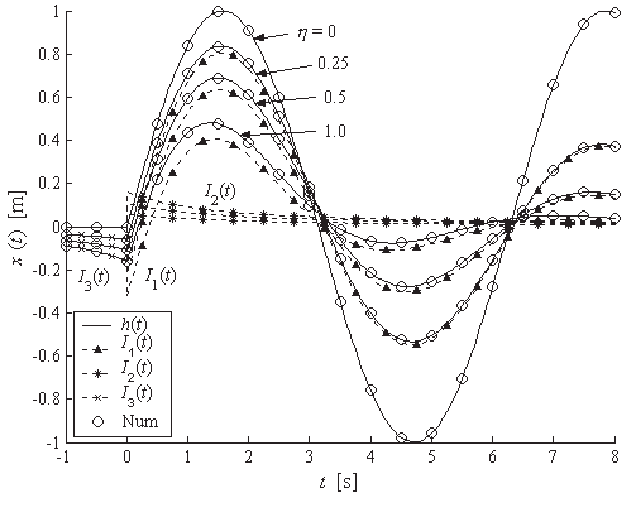
Fig. 6. Impulse response for the hysteretic damped SDOF system in function of η .